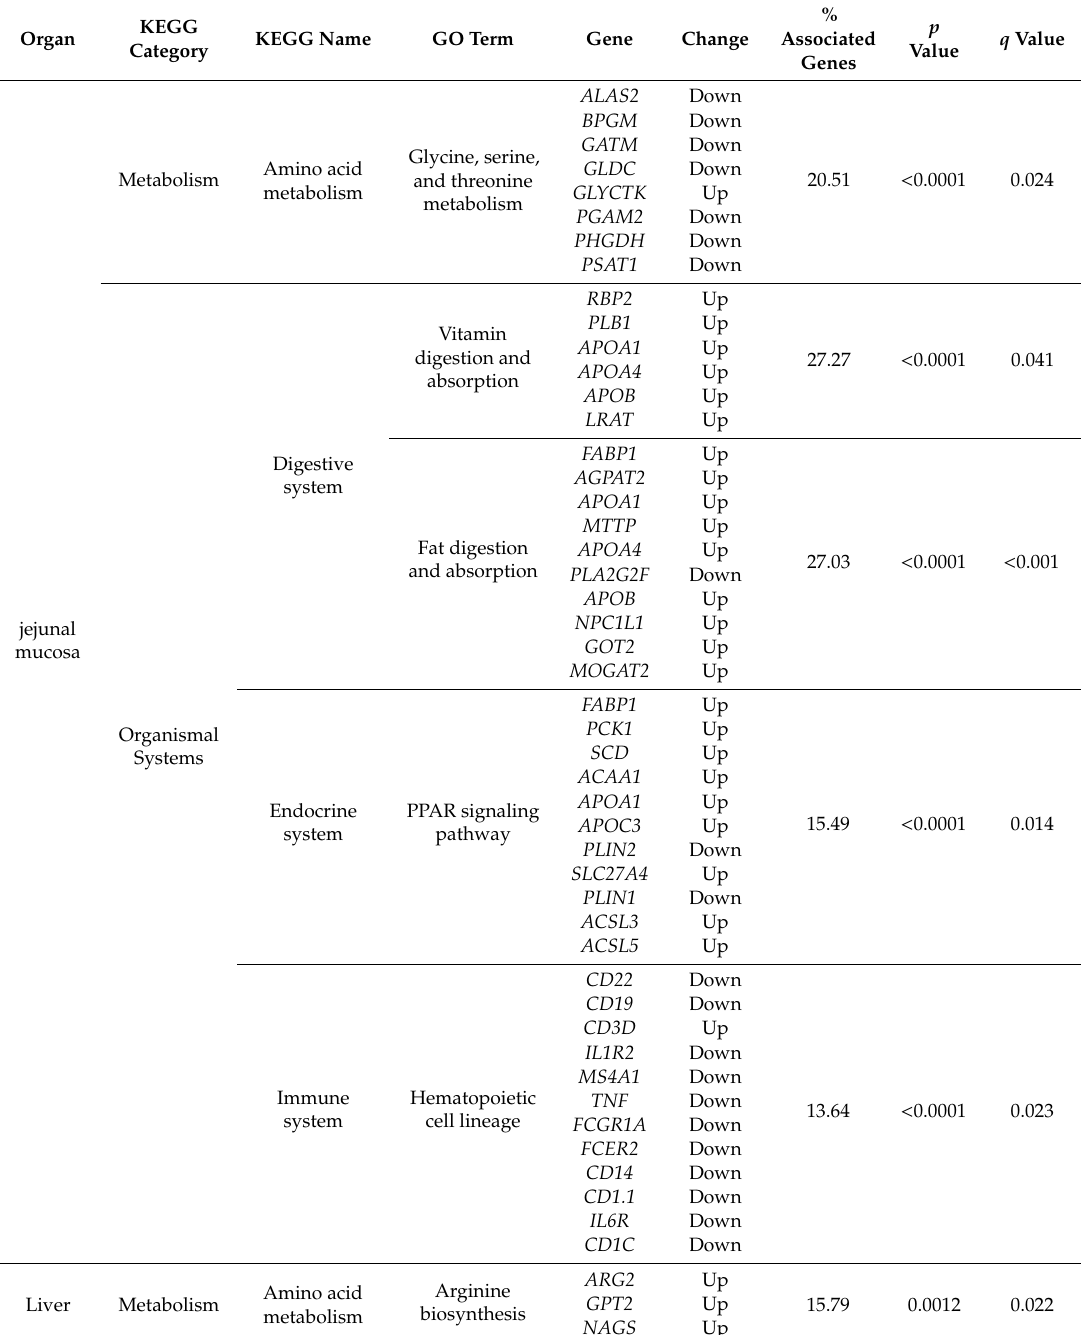
Table 4. Pathways enriched with di ff erentially expressed genes in the livers and jejunum mucosa of pigs induced by feeding one time daily when compared with feeding twice daily 1